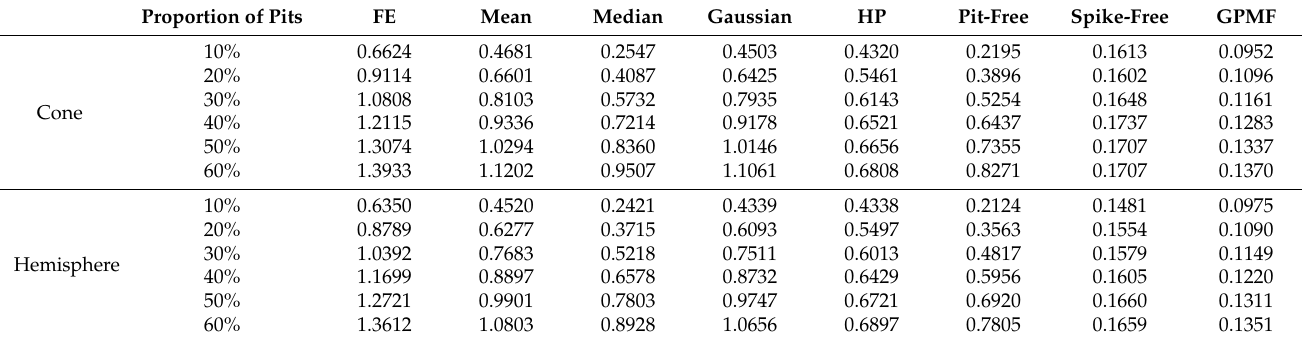
Table 1. The RMSE (m) of the comparison of CHM Reference against processed CHMs.